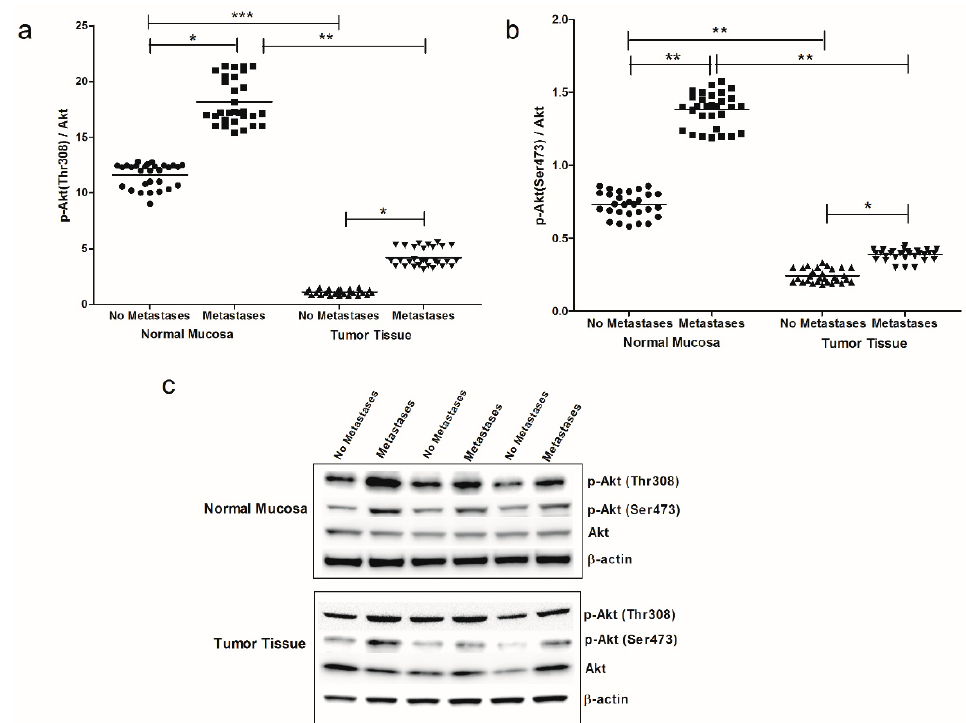
Figure 4. ( a ) p-Akt (Thr308) / Akt ratio protein values, detected in intestinal tissue of no metastases ( n = 29 patients) and with metastases patients ( n = 30 patients), in both normal mucosa and tumor tissue. ( b ) p-Akt (Ser473) / Akt ratio protein values detected in intestinal tissue of no metastases ( n = 29